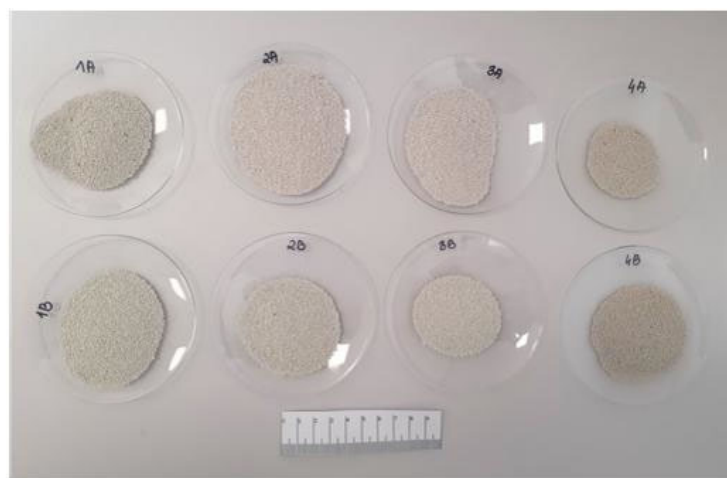
Figure 6. Produced agglomerates (second step of the dry agglomeration).